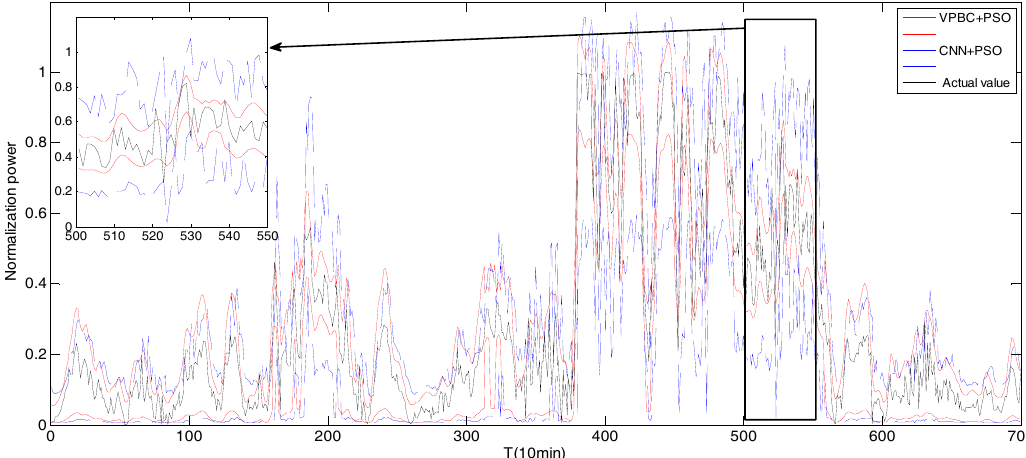
Figure 9. Forecasting results of the VPBC + PSO and CNN + PSO methods at 90% PINC.